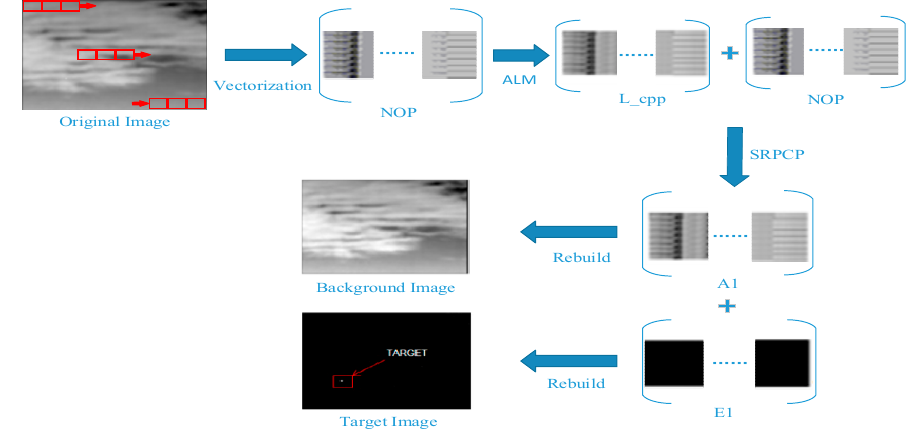
Figure 3. The target detection procedures of our method.